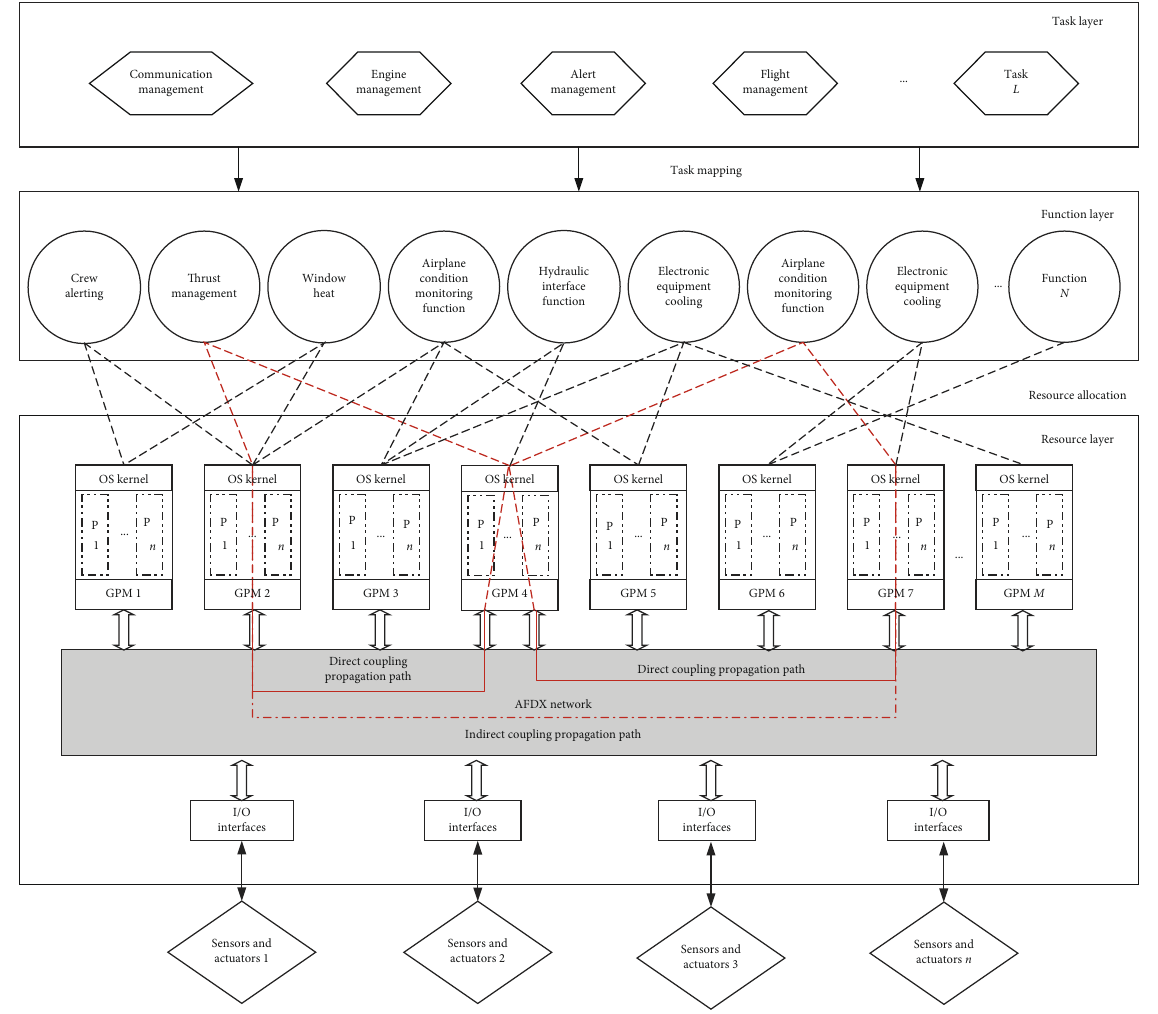
Figure 2: Schematic diagram of fault propagation in IMA